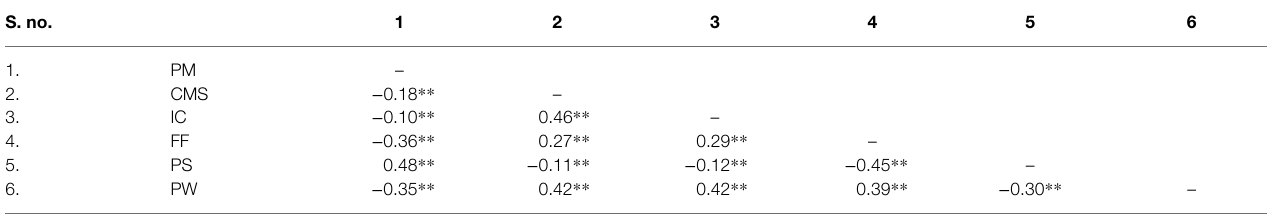
TABLE 5 | Intercorrelations of the PRFQ-12C and FF, PS, and PW. S. no.